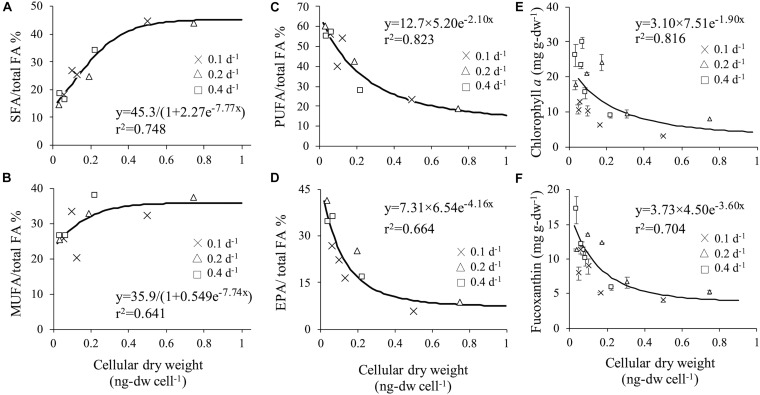
Correlation between cellular dry weight and SFA (A), MUFA (B), PUFA (C) and EPA (D). Correlation between cellular dry weight and chlorophyll a
(E) and fucoxanthin (F).